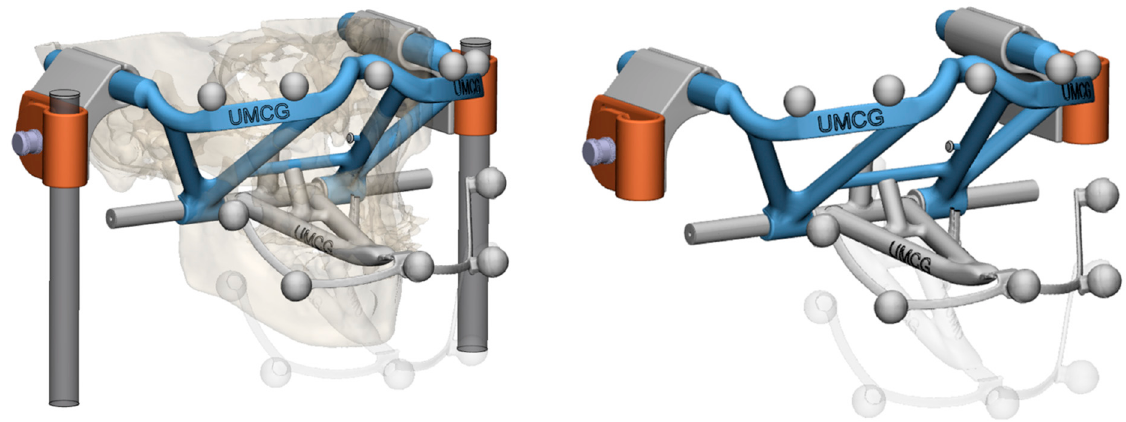
Figure 4. The phantom model that was designed in-house (University Medical Center Groningen /UMCG) for validation of the 4D-workflow. From a subject’s scan ( left ), the positions of the optical tracers were determined and the maxillary and mandibular frames were adapted to form a scaffold that could be rigidly connected to the CBCT scanner. The phantom allowed for rotation along the mandibular axis ( right ), resulting in a simulated 25 degrees opened mouth (transparent).